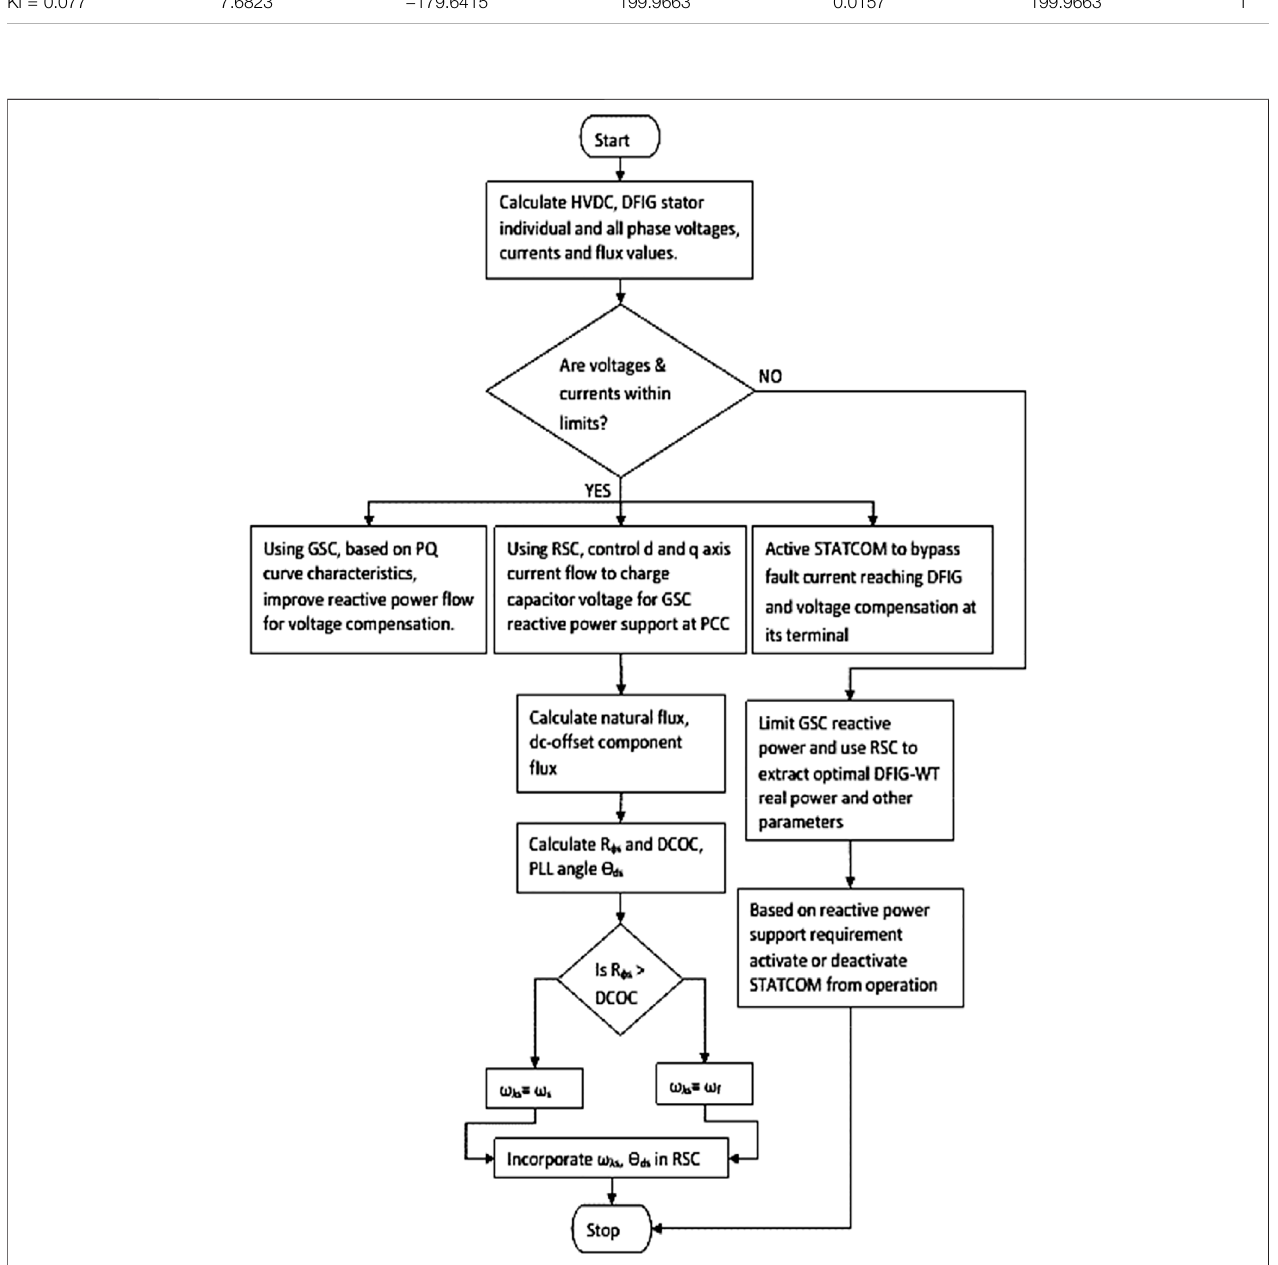
FIGURE 6 | Improved FOC fl ow chart adopted for the RSC